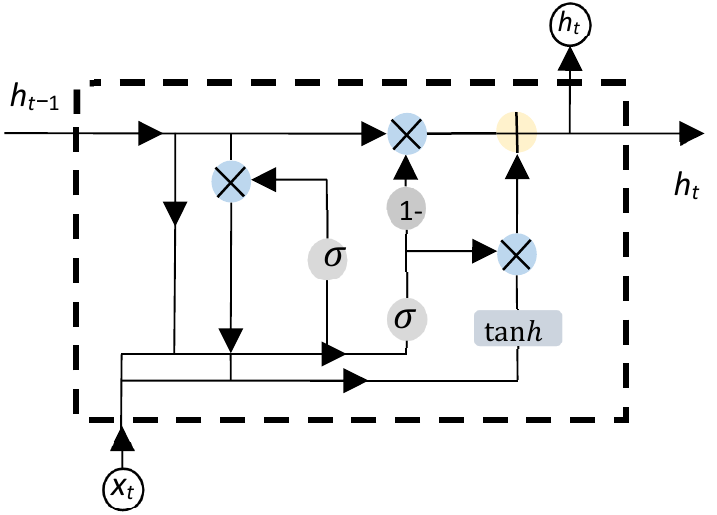
Figure 3. Structure of the gated recurrent unit.